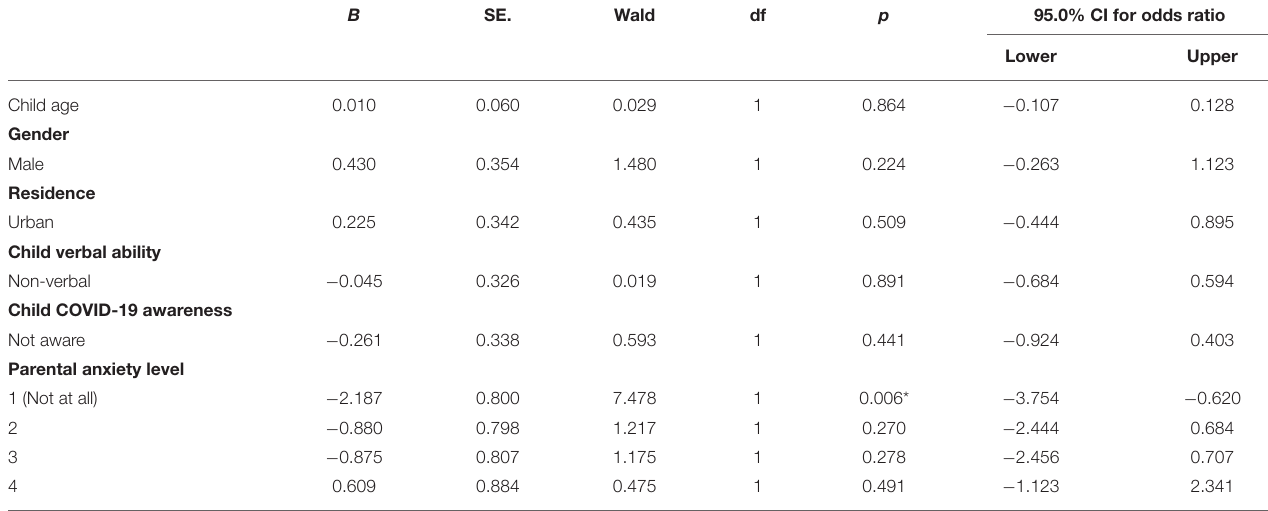
TABLE 3 | Ordinal regression predicting child anxiety